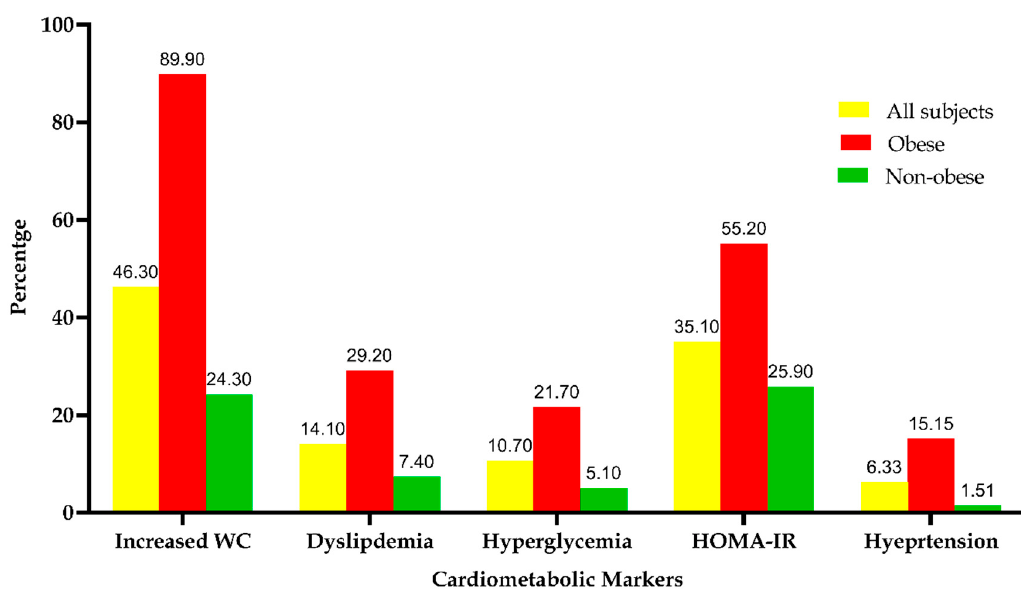
Figure 3. Frequency of metabolic syndrome components among study subjects based on obesity status. Bars represent the frequency distribution (%) of metabolic syndrome components among all study subjects, obese subjects and non-obese subjects based on BMI cut-o ff values.